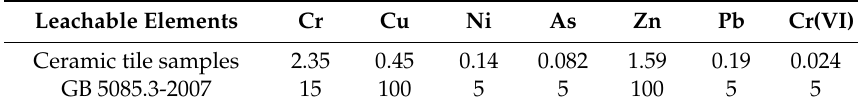
Table 4. Concentrations of leachable elements from tiles sintered with Fe/Cr = 2.0 at 1150 °C and 30 min (mg/L).